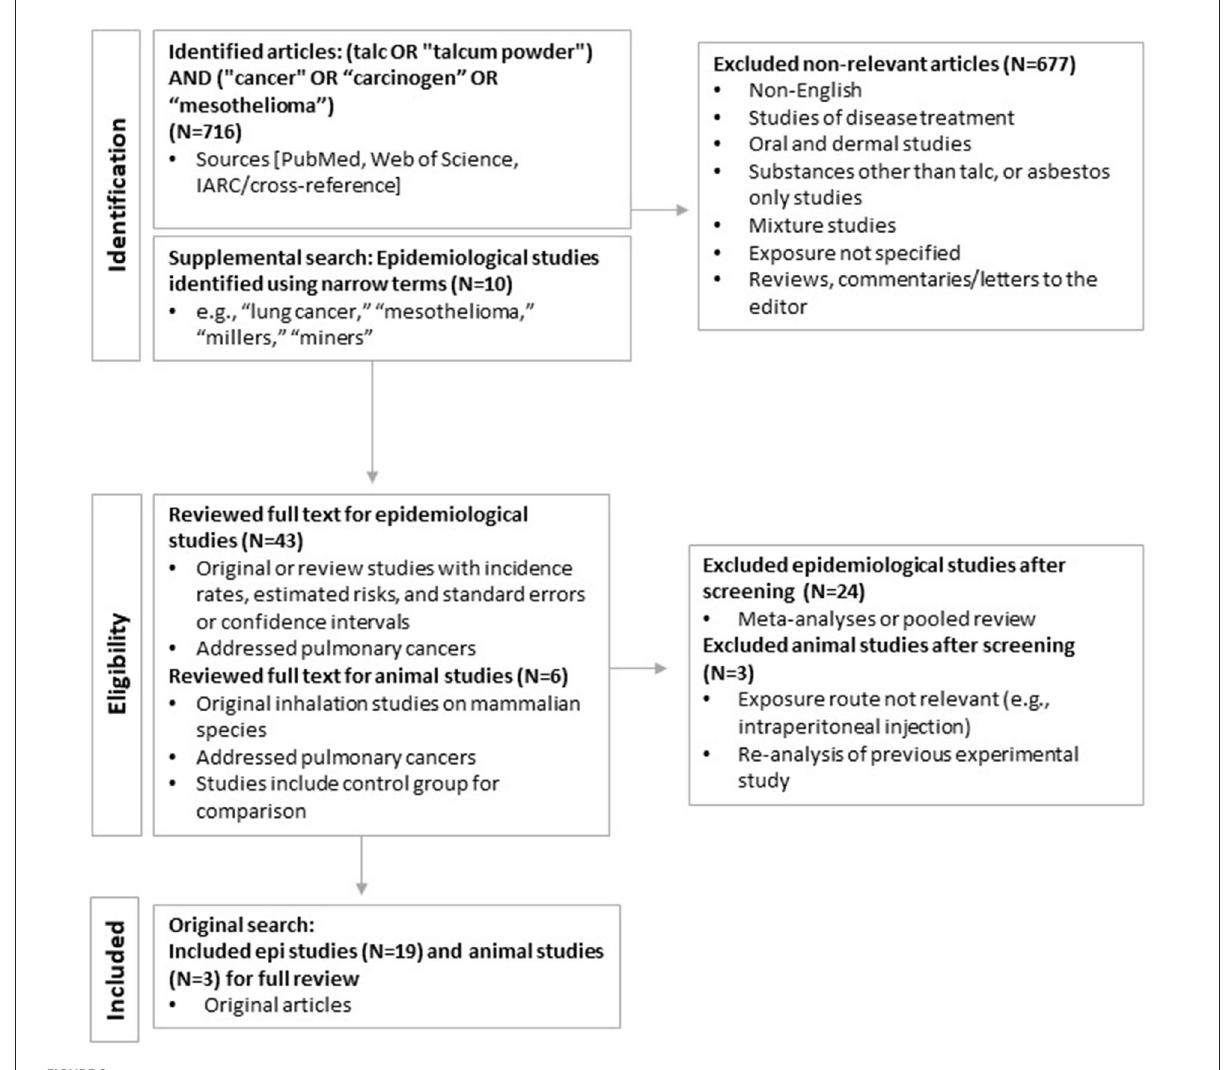
FIGURE2 Literature search and selection